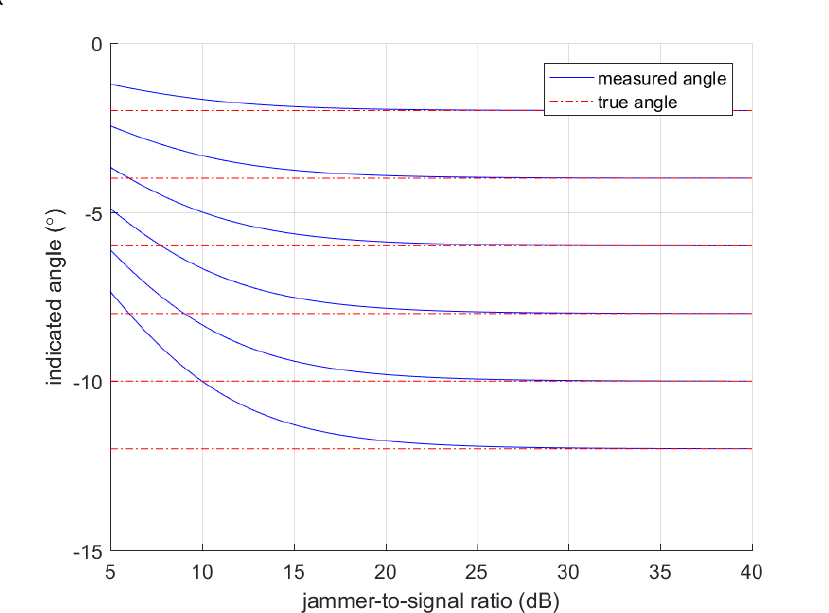
Figure 5. The measured and true angles for target separations of 2, 4, 6, 8, 10, and 12 degrees, plotted against the